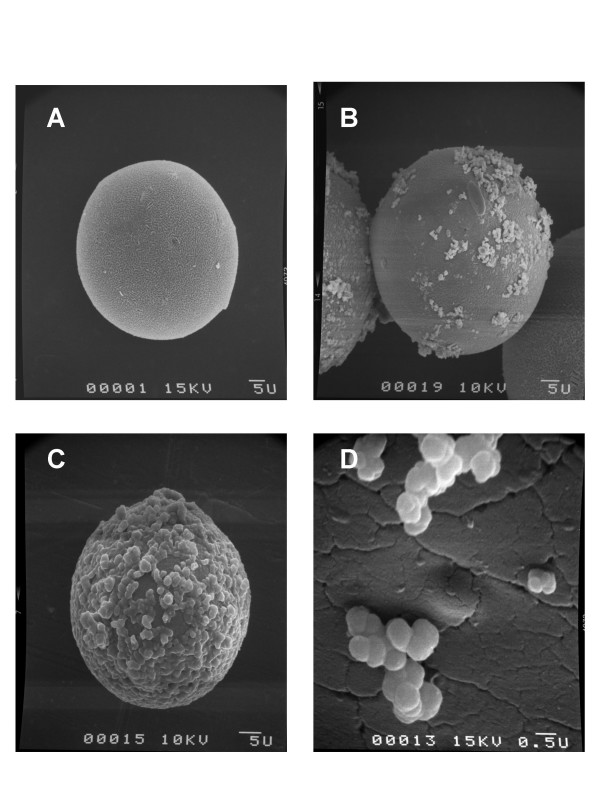
SEM observation of retained liposomes on G-25 fine beads. A : Sephadex beads non incubated with liposomes, fixed with glutaraldehyde, washed, stained and prepared for SEM. B, C, D: Liposomes, containing PC and PE (6/4), retained by a 2 mL sephadex G-25 fine columns were fixed by glutaraldehyde, washed, stained and prepared for SEM observations.